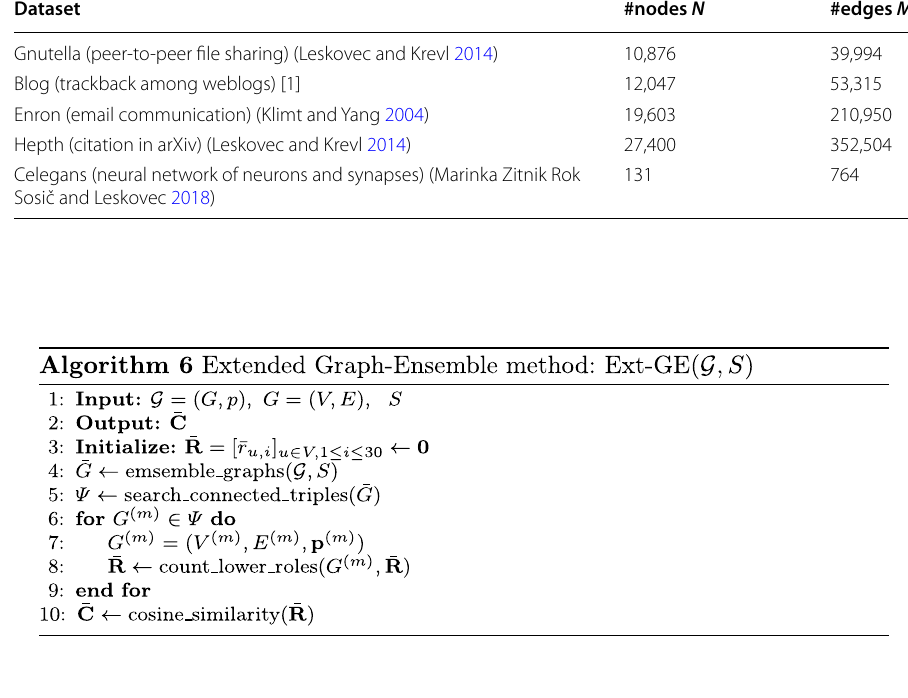
Table 2 Basic statistics of datasets